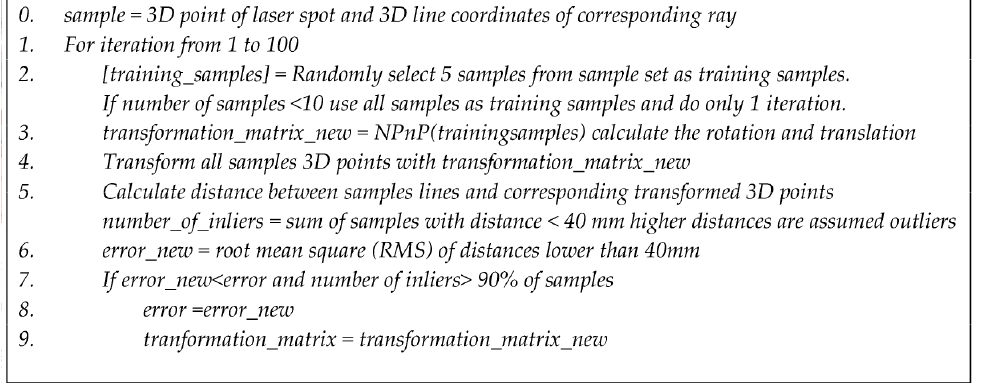
Figure 5. Pseudocode implementation Ransac algorithm. NPnP =